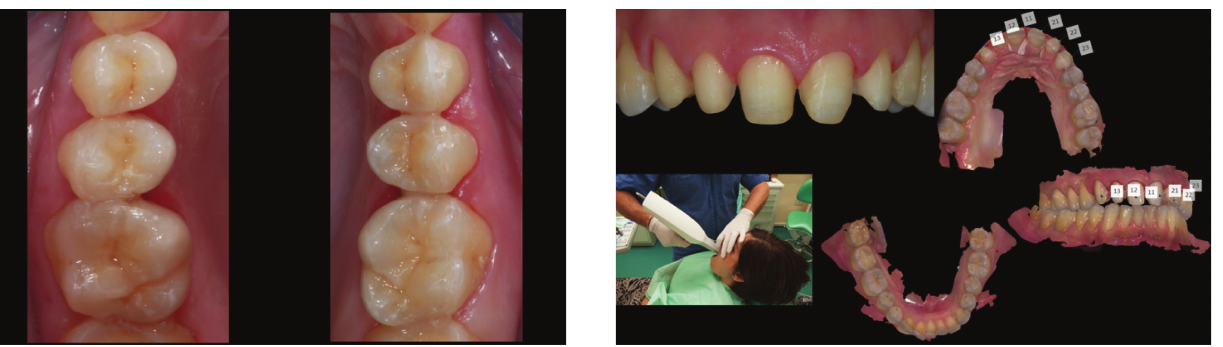
Figure 6: Case 2 (Bilayered Lithium Disilicate Veneer Replace- ment). The old veneers were carefully removed under stereomicro- scopic control; after the new supragingival preparations, an intraoral scanningdevice(3-ShapeD700)wasusedtotakedigitalimpressions of both dental arches.